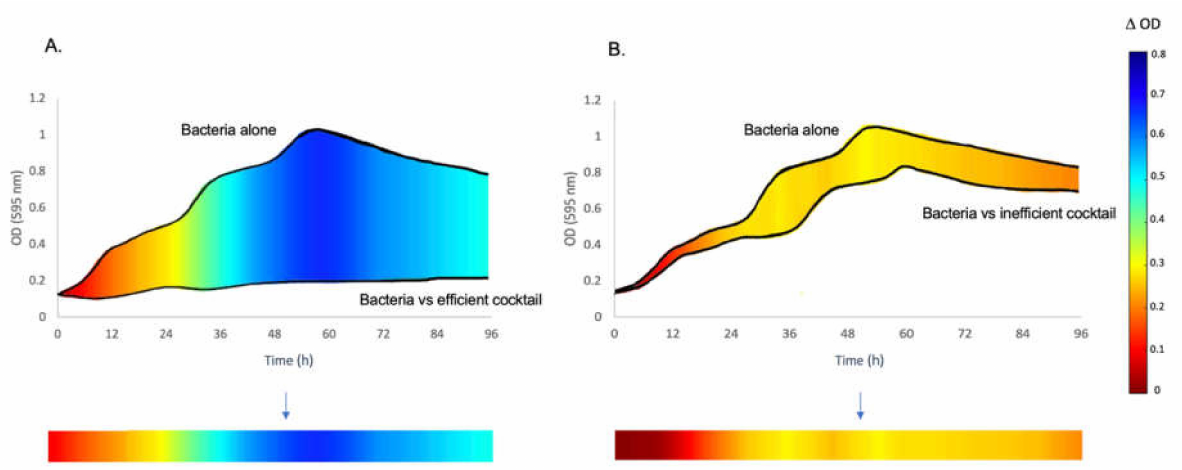
Figure 1. Example of the schematic representation of the ∆ OD values of bacterial growth with or without phages. To simplify the presentation of the results for the large number of conditions tested, a schematic representation was developed to show the phage effectiveness in inhibiting bacterial growth. ( A ). The two growth curves show the OD of the bacterial strain grown alone and in the presence of the best phage cocktail. The colored line below the graph represents the ∆ OD of the growth curve of bacteria alone minus the one of bacteria in the presence of phages based on the range shown on the right of the figure. ( B ). Same principle as in panel A, but the bacteria were in the presence of phages that were not effective growth inhibitors. When the bacterial growth is highly inhibited, the color of the line tends to blue. No inhibition corresponds to red